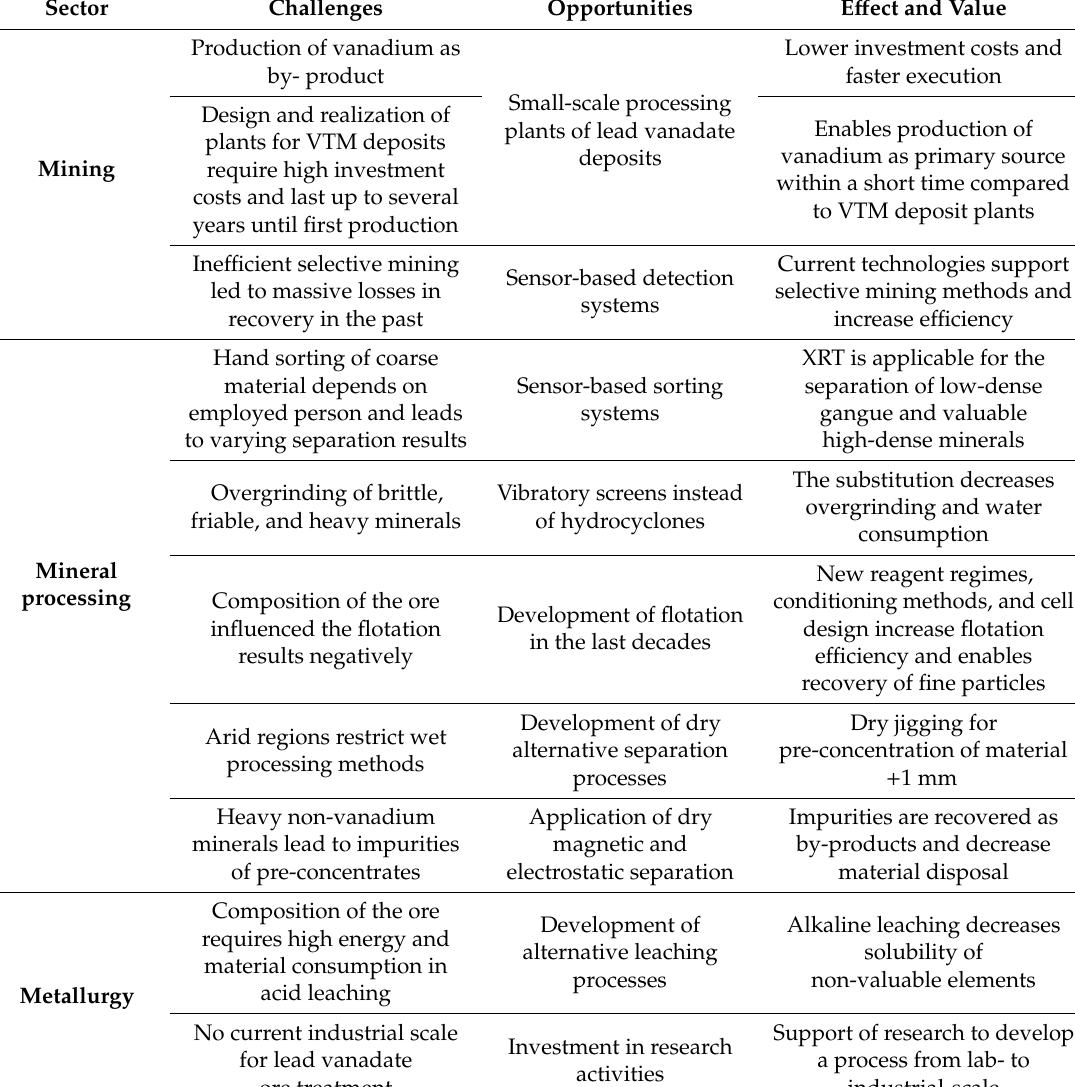
Table 5. Challenges and opportunities of mining and processing of lead vanadate